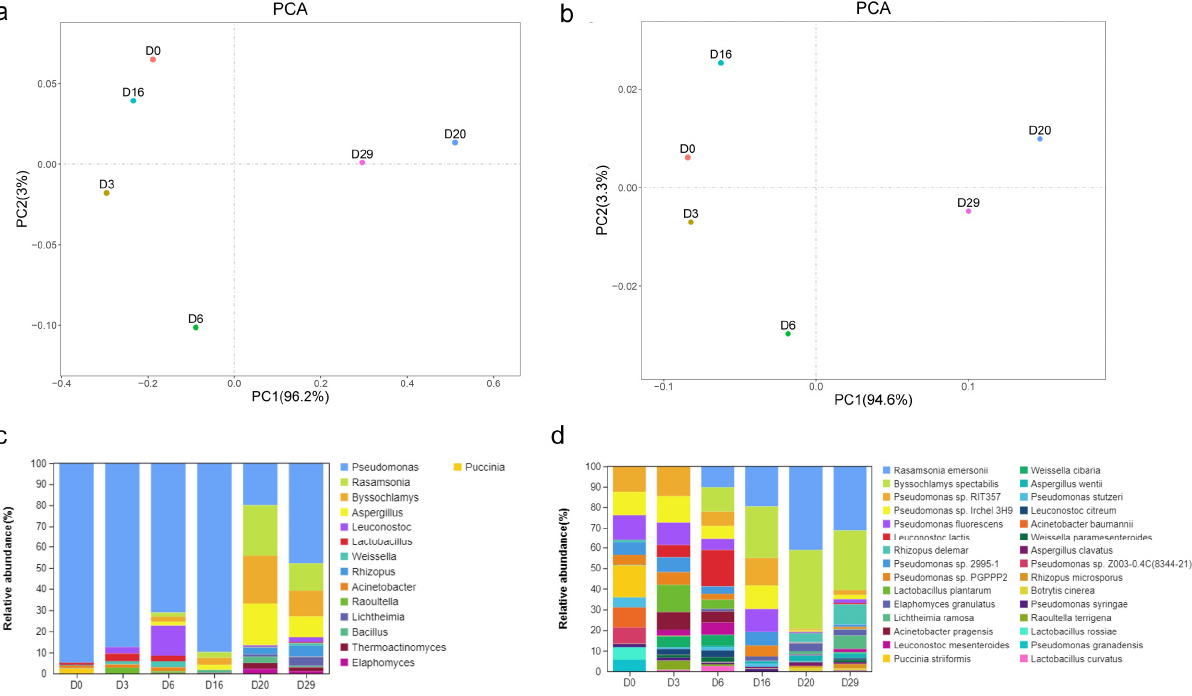
Figure 4. Species distribution and composition during Daqu fermentation stages. PCA analysis at genus level ( a ), species level ( b ), different color dots represent different samples, species composition at genus level ( c ), species level ( d ).